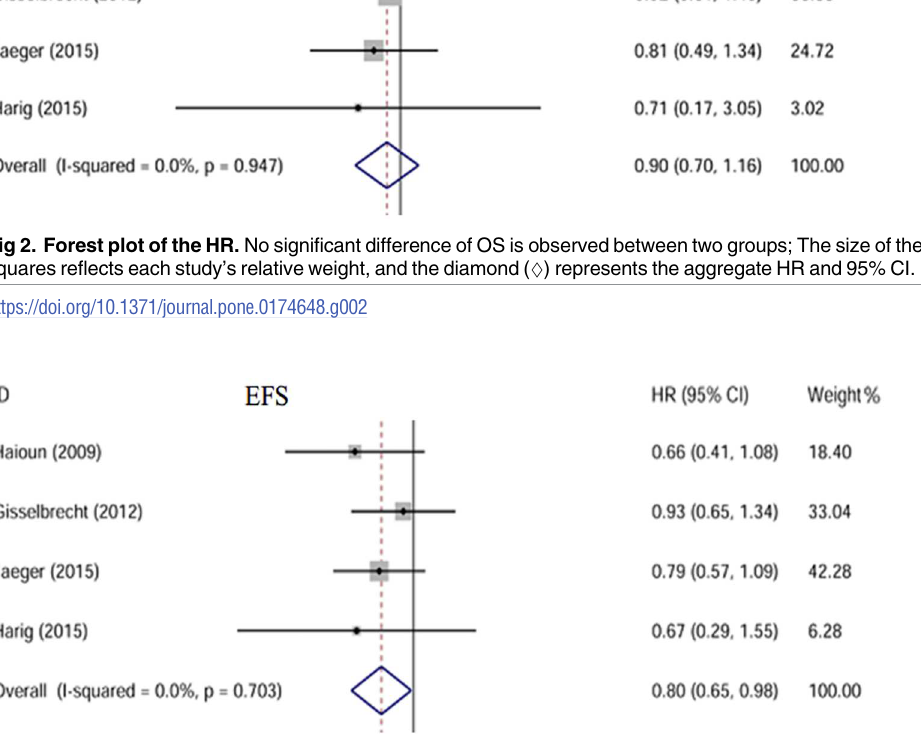
Fig 3. Forest plot of the HR. EFS is significantly improvedin patients receivingrituximabmaintenance.